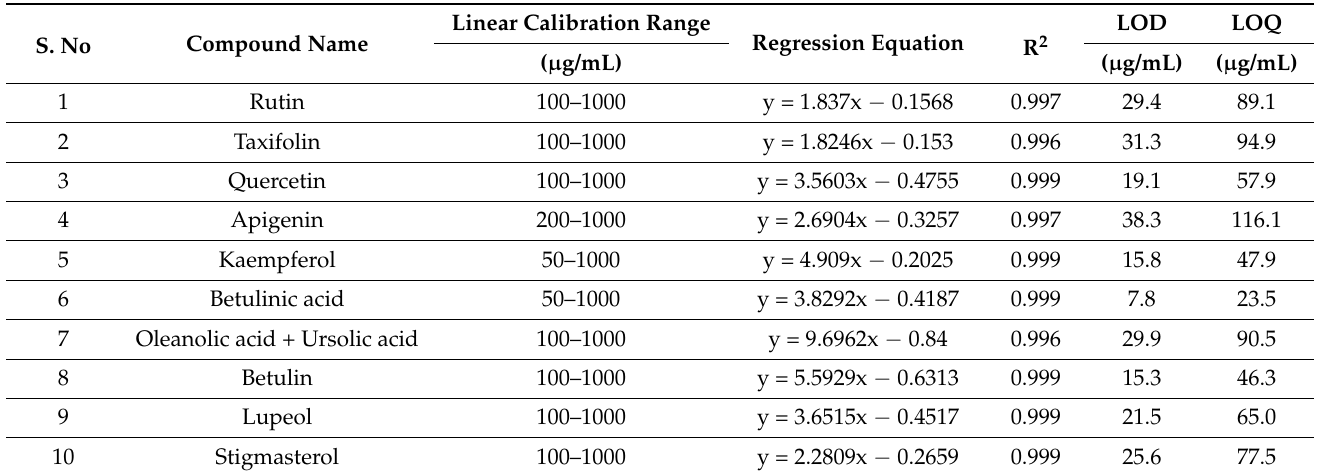
Table 4. Calibration values (R 2 , LOD and